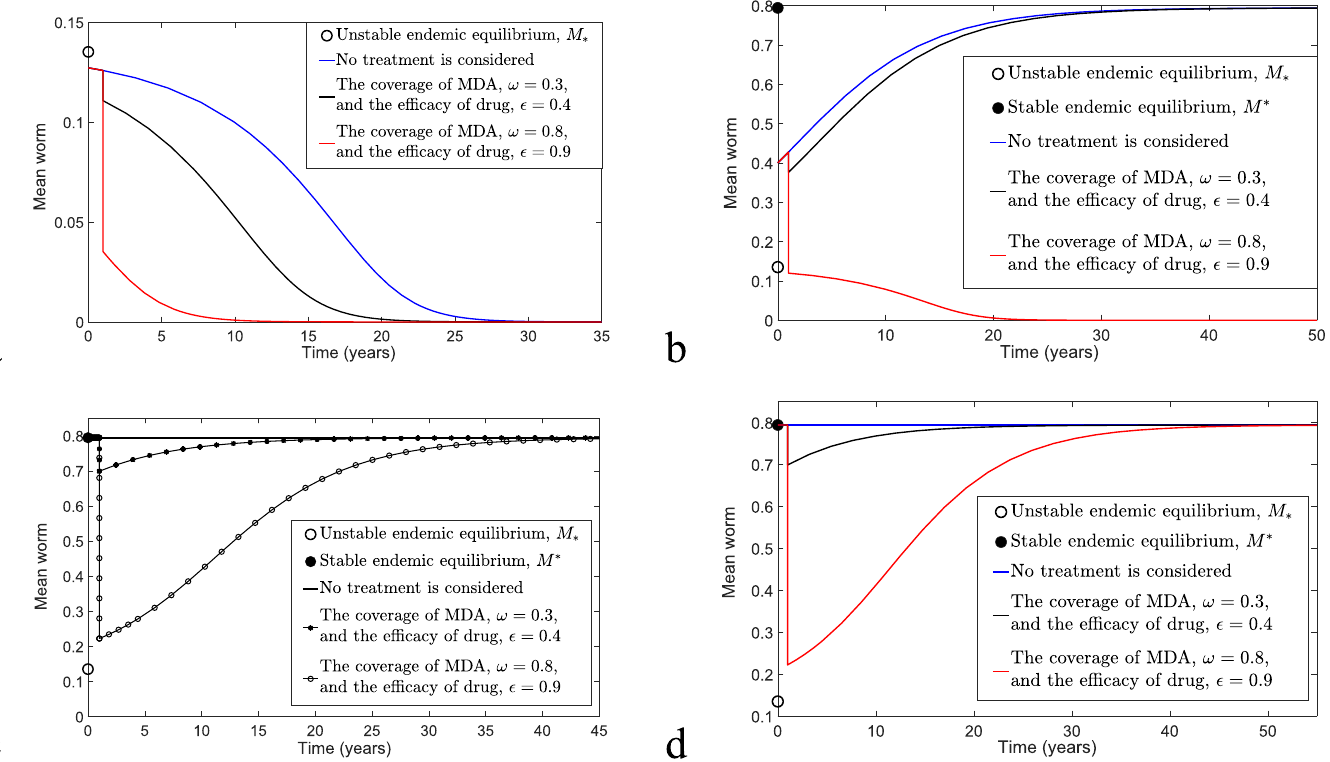
Fig 2. Transmission dynamics of model (3) and (4) considering no application of MDA and one round of MDA at time t = 1 with k = 0.05 and R 0 = 2. (a) M 0 < M � . (b) M � < M 0 < M � . (c) M 0 = M � . (d) M 0 > M � .